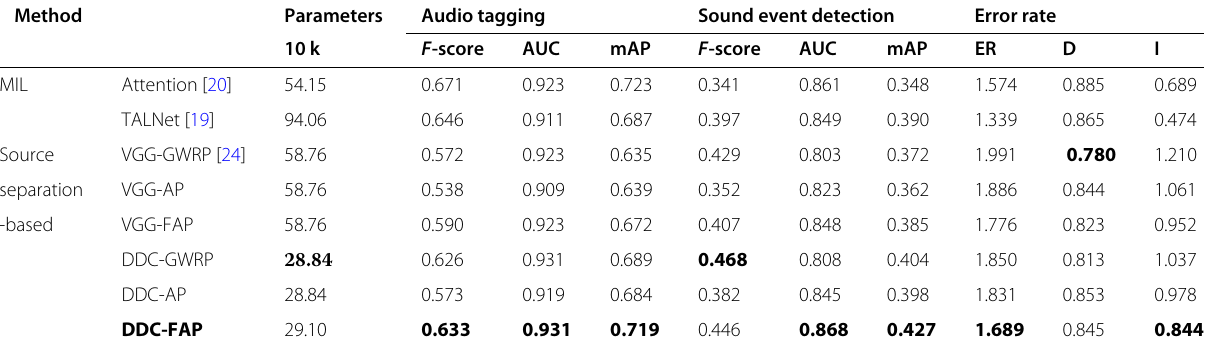
Table 6 The results of MIL and source-separation-based methods Method